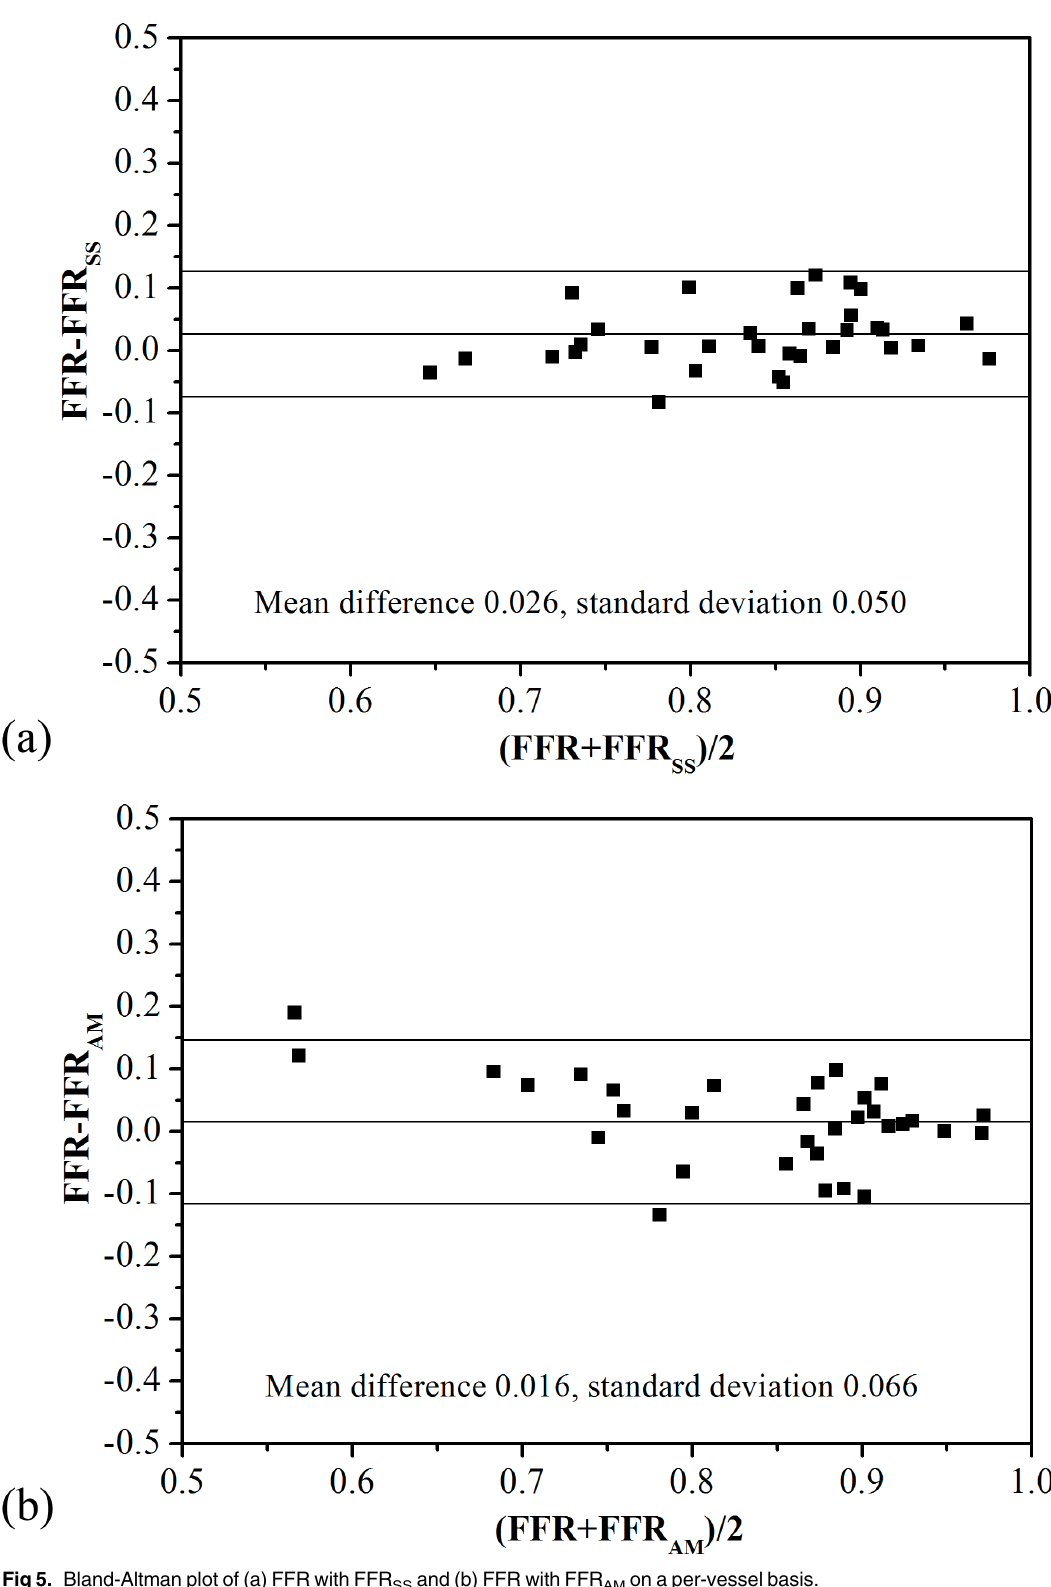
Fig 5. Bland-Altman plot of (a) FFR with FFR SS and (b) FFR with FFR AM on a per-vessel